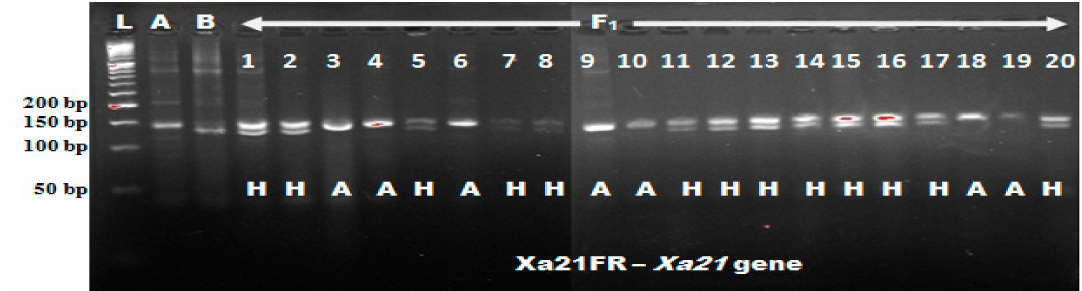
Figure 2. Genotyping and foreground marker-assisted selection of F 1 progenies using polymorphic tightly linked foreground marker. A: Putra-1; B: IRBB60. H: heterozygote. 1, 2, 3, ... , 20 are some F 1 plants. Electrophoresis running on 3% metaphor agarose gel stained with 10 µ L of gel view per 100 mL. L: 50 bp DNA